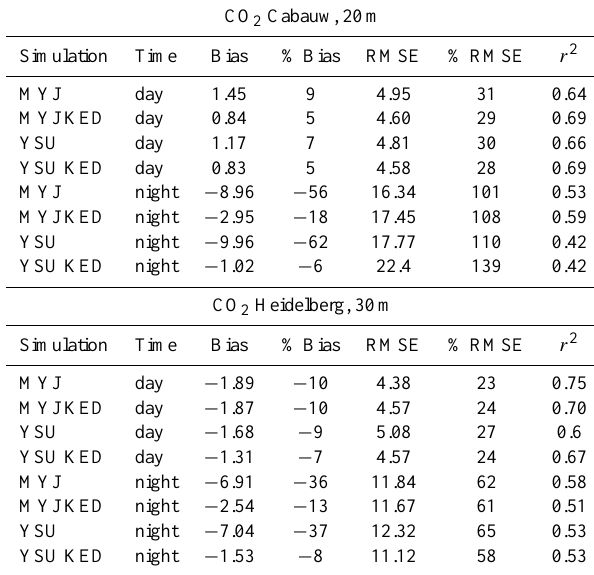
Table 3. Results of STILT–data CO 2 comparison at Cabauw (up- per half) and Heidelberg (lower half), considering STILT/MYJ and STILT/YSU simulations (rows: MYJ, YSU). Also shown are the statistics of the STILT simulations using KED-optimized MHs (rows: MYJ KED, YSU KED). Bias and RMSE were normalized with the observed CO 2 subtracting STILT simulated background concentrations (columns % Bias and % RMSE). Day denotes hours 10:00–12:00UTC and night